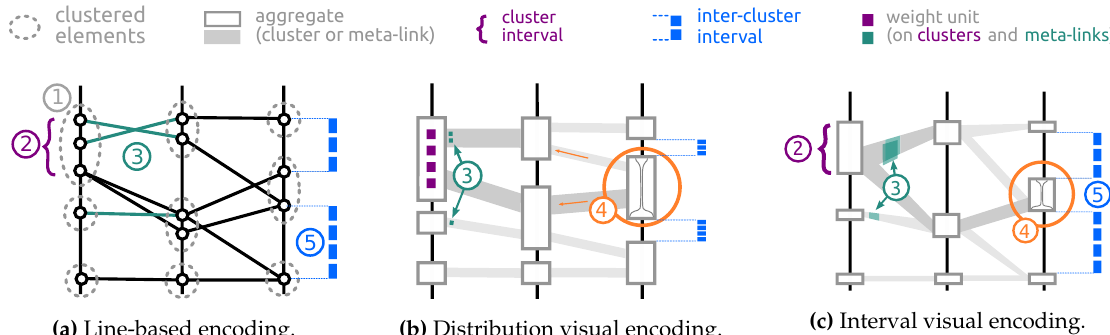
Figure 4. Comparison of the two visual encodings proposed for abstract parallel coordinates compared to the line-based version displayed on ( a ). On ( a ), 1 four elements forming the example cluster and 2 two sets of connections forming two example meta-links. On ( b ), cluster and meta-links size encodes their weight. Meta-links anchor points on clusters are sorted relative to their destination to limit crossings as shown on 3 . On ( c ), cluster sizes correspond to their interval size. Meta-link colors and size respectively depends on their weight and ends. They are depth sorted by weight and attached on each cluster ends to the highest density point as represented on 3 . On both ( b ) and ( c ), the inner-cluster smoothed histogram is represented on 3 . Finally, 4 shows that inter-cluster intervals can be compared, per-axis, on both